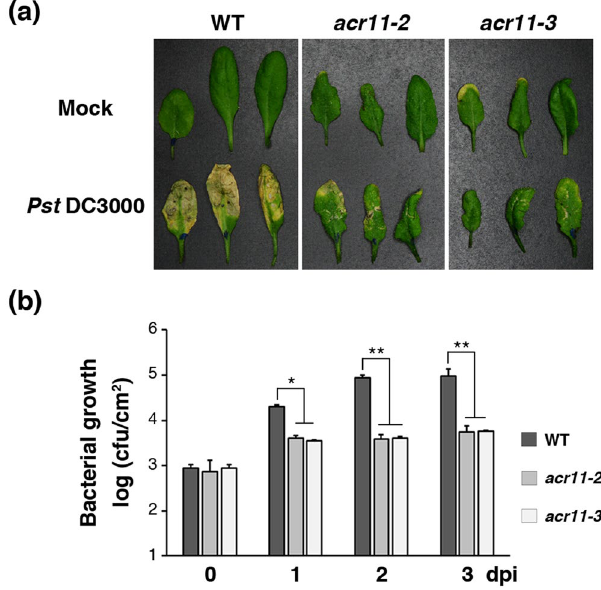
Figure 7. Enhanced disease resistance in 5-week-old Arabidopsis acr11 mutants. ( a ) Symptoms of wild- type (WT), acr11-2 and acr11-3 rosette leaves 3 days after syringe infiltration with Pseudomonas syringae pv. tomato DC3000 ( Pst ). ( b ) Growth of Pst in Arabidopsis WT, acr11-2 and acr11-3 mutants. Bacterial titers were evaluated at 0 to 3 days post inoculation (dpi). Results are means ± SD from three independent experiments. Asterisks indicate significant differences ( * P < 0.05; ** P < 0.01; Student’s t test) compared to the